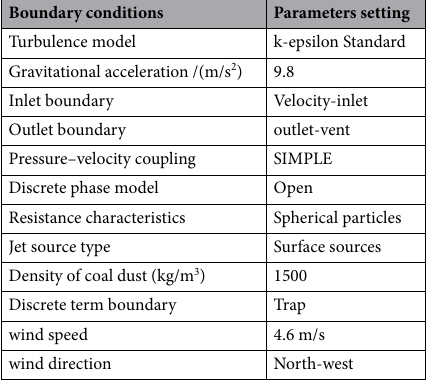
Table 2. Calculation model parameters of micro-motion process.